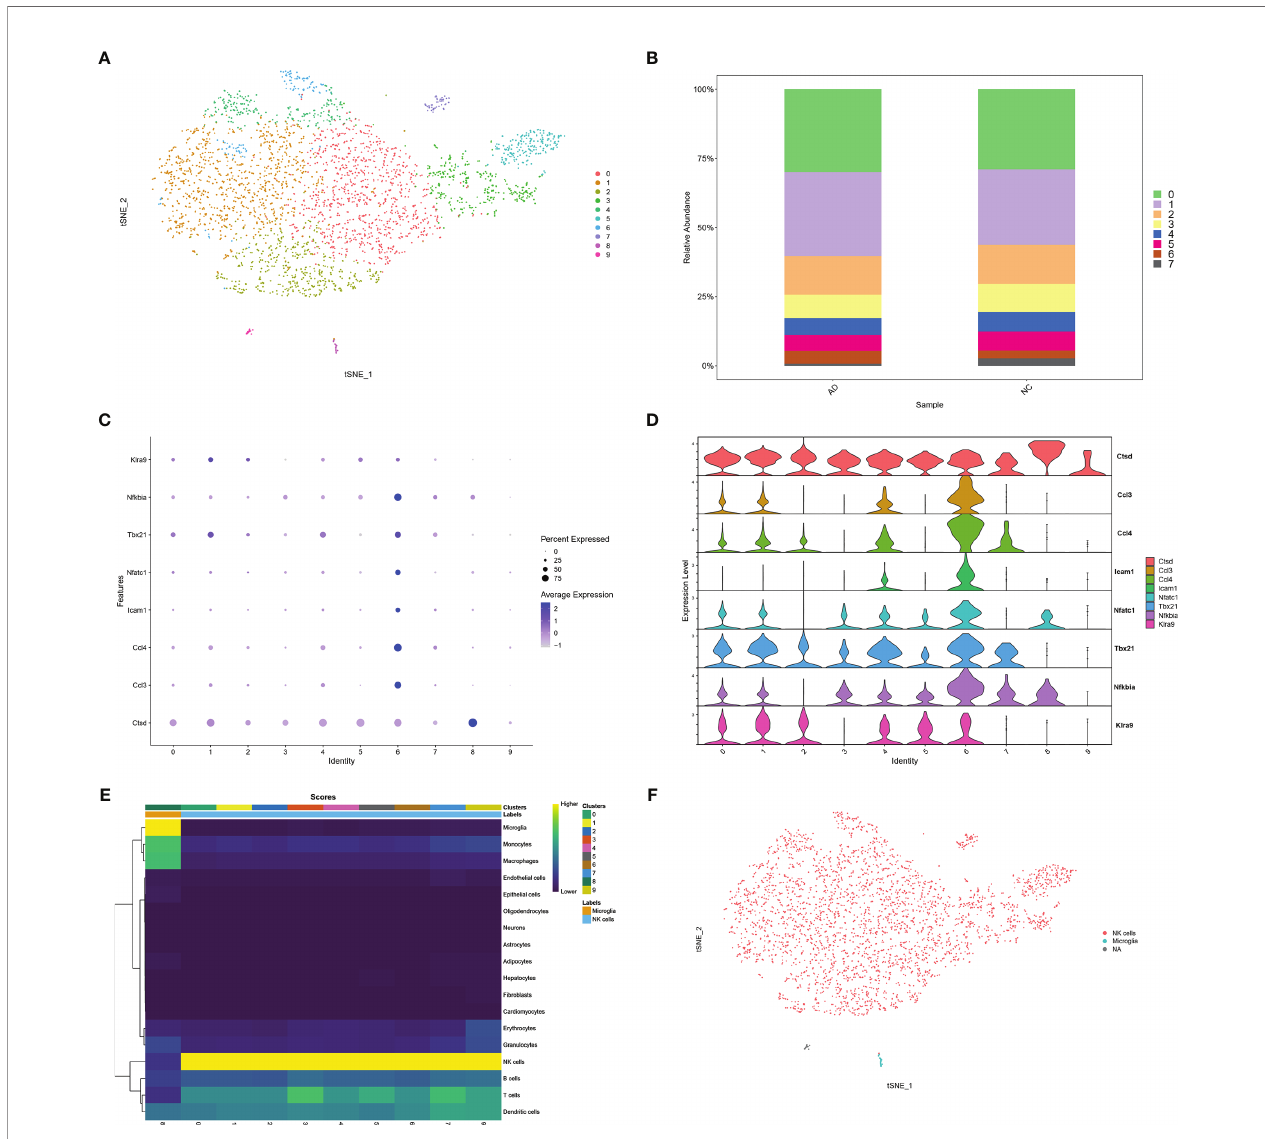
FIGURE 6 | scRNA analysis of NK cells in AD brain. (A) tSNE projection of 3,250 cells from all NK cells isolated from brain of AD mice. (B) Cluster distribution in each sample. (C) Dot plot of NK related genes. (D) Violin plot of NK related genes. (E) Score plot of cluster annotation by singleR package. (F) tSNE projection of annotated